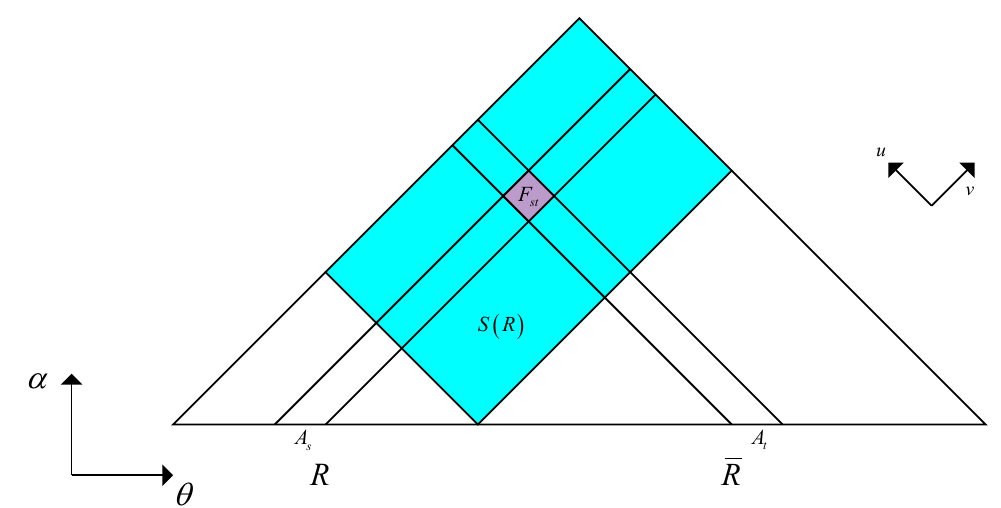
Figure 10 . The entanglement entropy of the subregion R in the boundary CFT can be represented as the volume of the causal diamond ♦ R (in blue) in the kinematic space, while the flux F st of a thread bundle connecting two elementary regions A s and A t is precisely given by the volume of the diamond region ♦ st (in